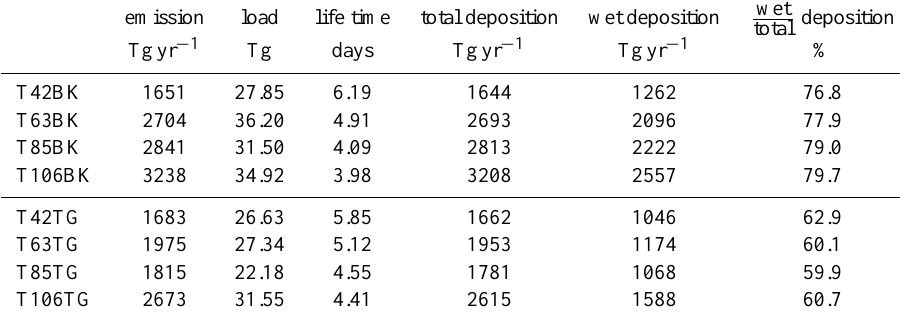
deposition total